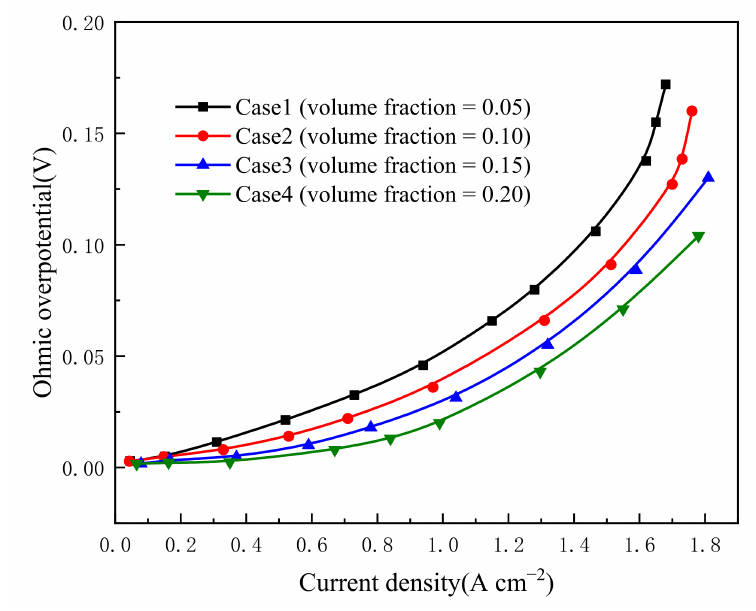
Figure 12. Effect of ionomer volume fraction on Ohmic